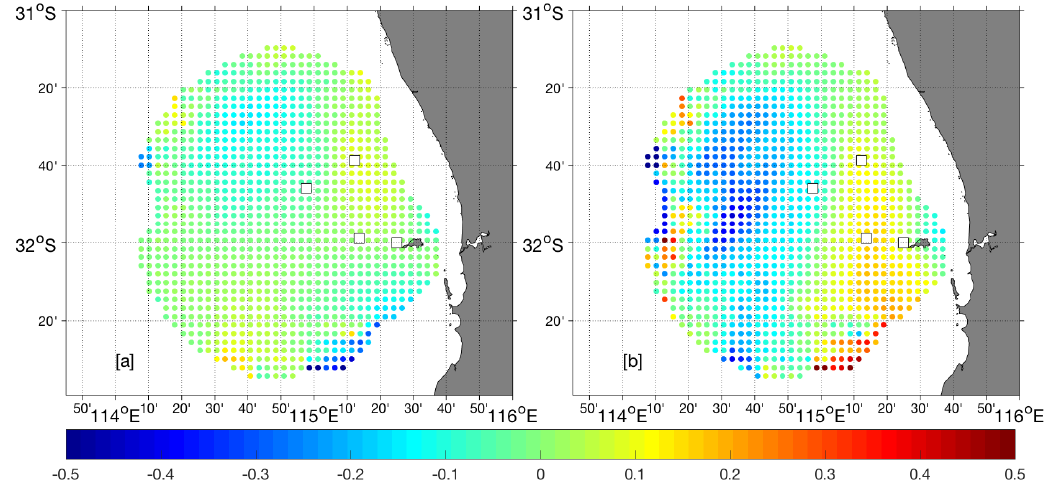
Figure 6. Spatial distribution of the mean bias (m/s) for the two velocity components between WERA and merged SeaSonde–WERA: ( a ) refers to the zonal component; ( b ) refers to the meridional component. Locations of the moorings are marked as white squares.